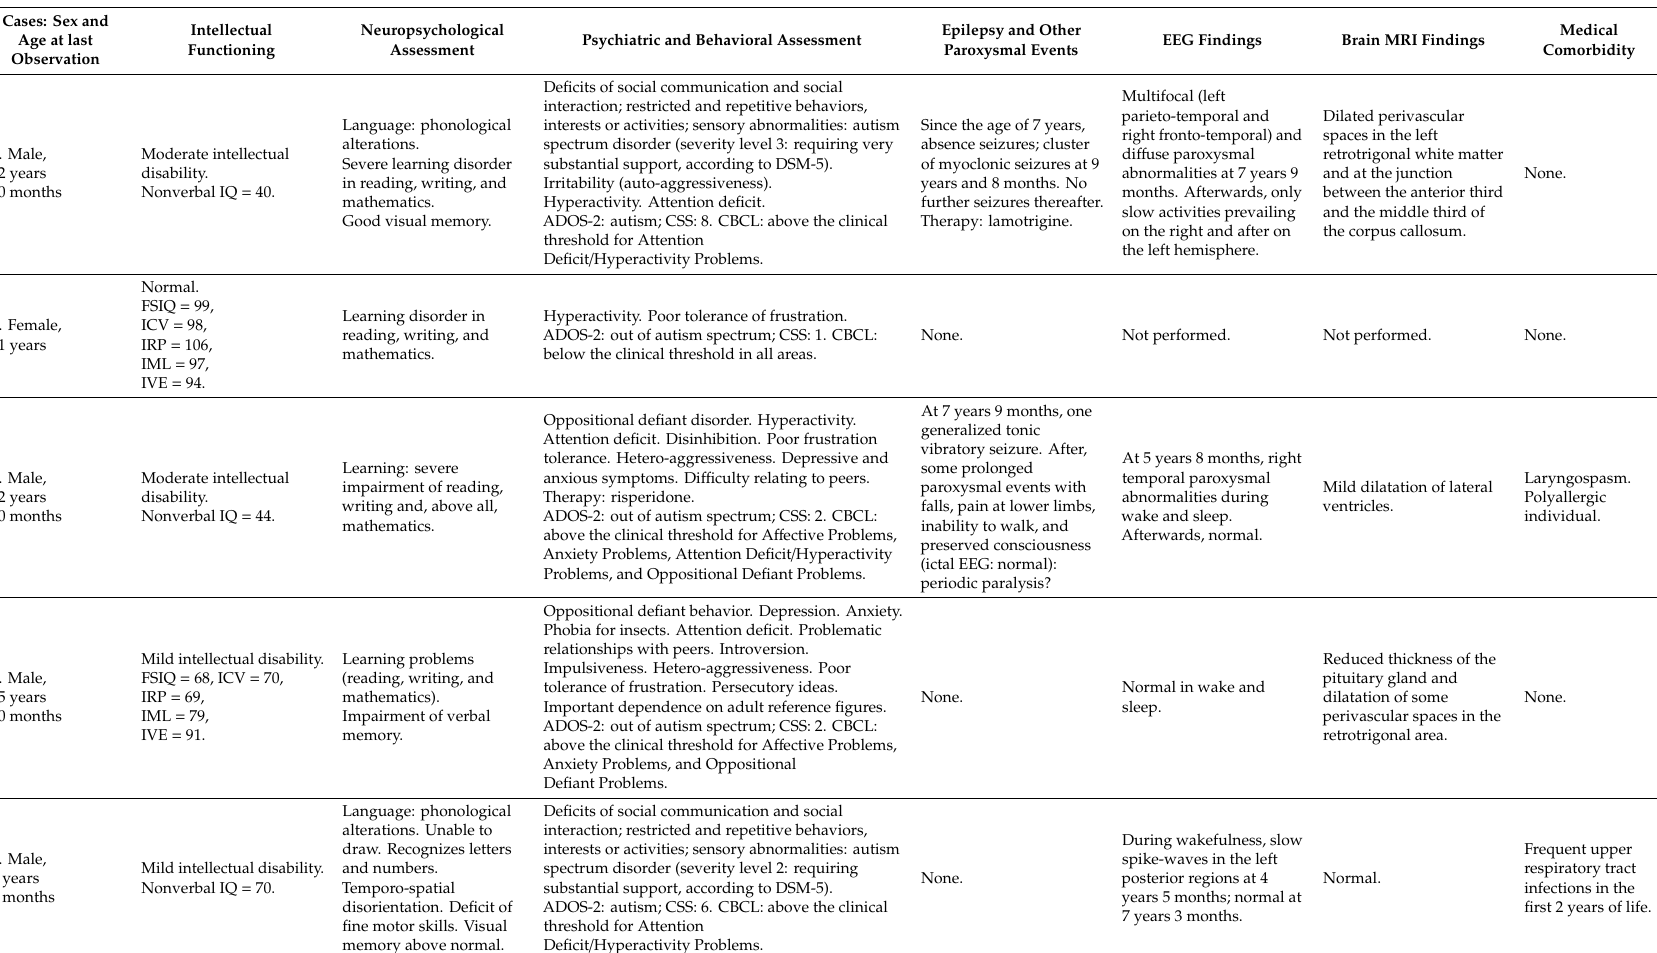
Table 2. Neuro-behavioral, clinical, and instrumental features of five cases with